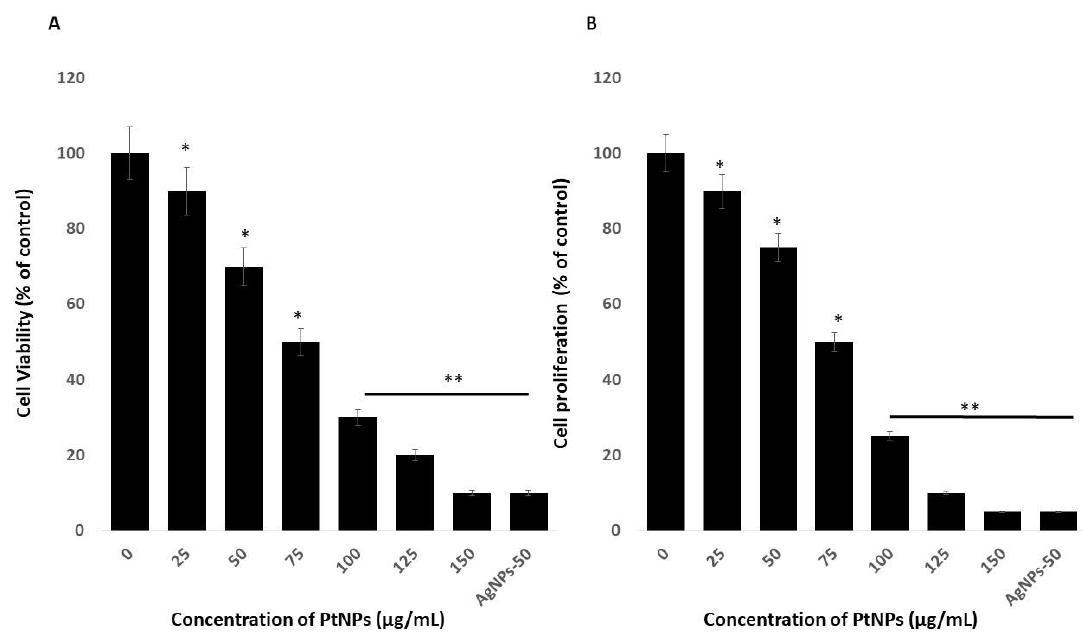
Figure 2. E ff ect of PtNPs on cell viability and proliferation of THP-1 cells. ( A ) Viability of THP-1 cells was determined after 24 h of exposure to di ff erent concentrations of PtNPs (25–150 µ g / mL). ( B ) Proliferation of THP-1 cells was determined using the 5-bromo-2’-deoxyuridine (BrdU) assay after 24 h of exposure to di ff erent concentrations of PtNPs (25–150 µ g / mL). The treated groups showed statistically significant di ff erences from the control group by the Student’s t -test (* p < 0.05). * significant; ** highly significant .